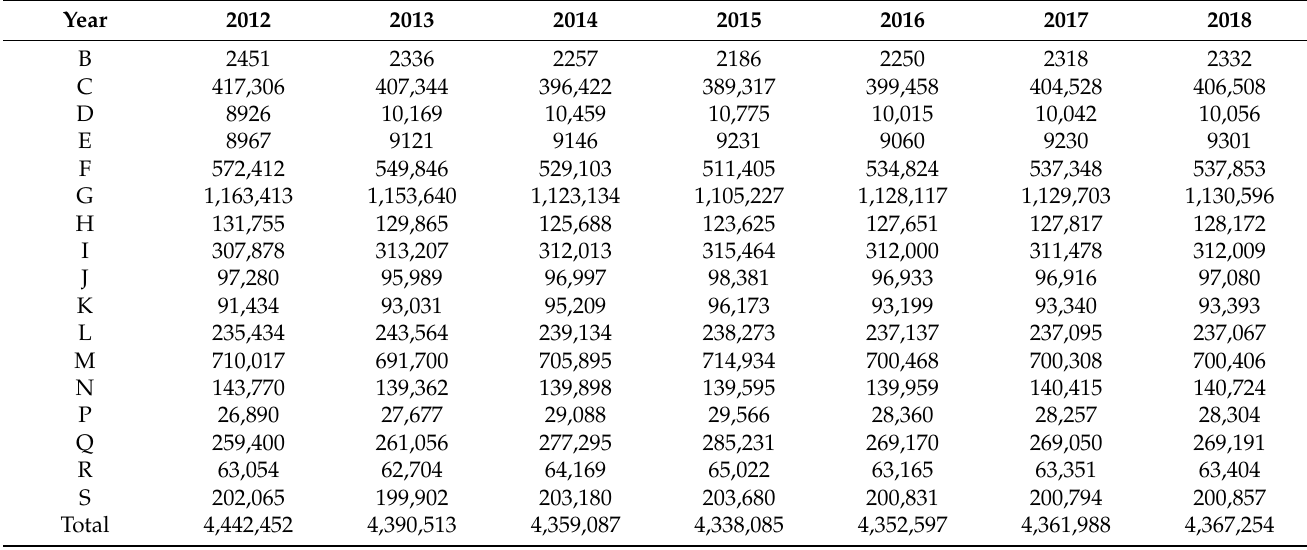
Table 2. Total number of enterprises in Italy (2012–2018).